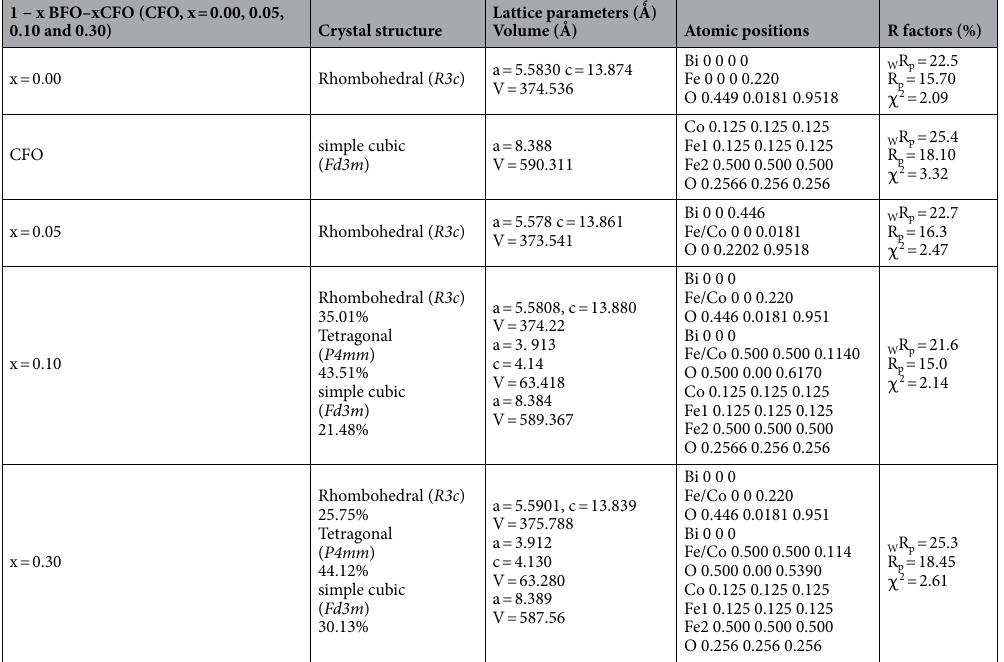
1 − x BFO–xCFO (CFO, x = 0.00, 0.05, 0.10 and 0.30) Crystal